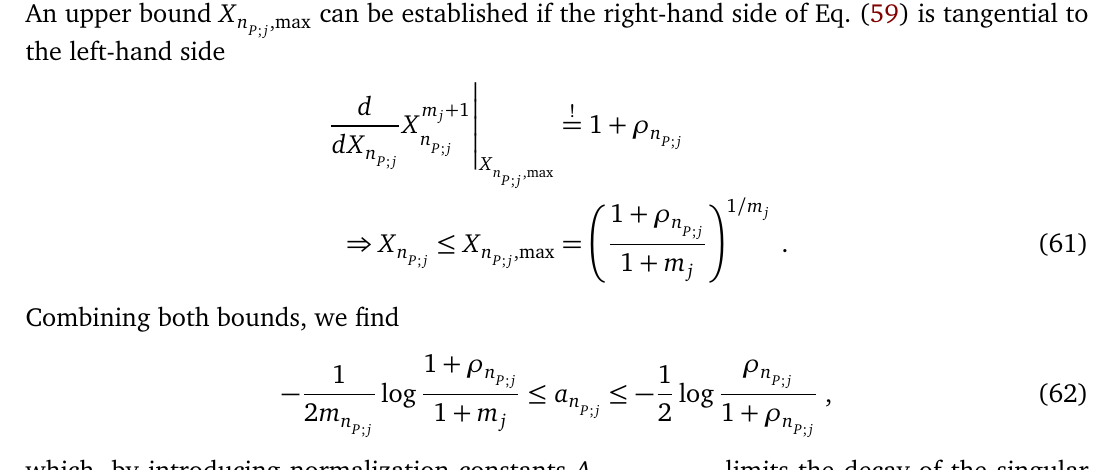
Figure 10: Left (purple) and right (green) hand sides of Eq. (59), X intersections are solutions for distinct pairs of ( ρ